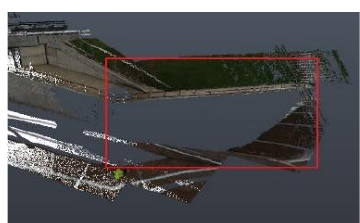
Figure 4. The occlusion of point cloud on the retaining